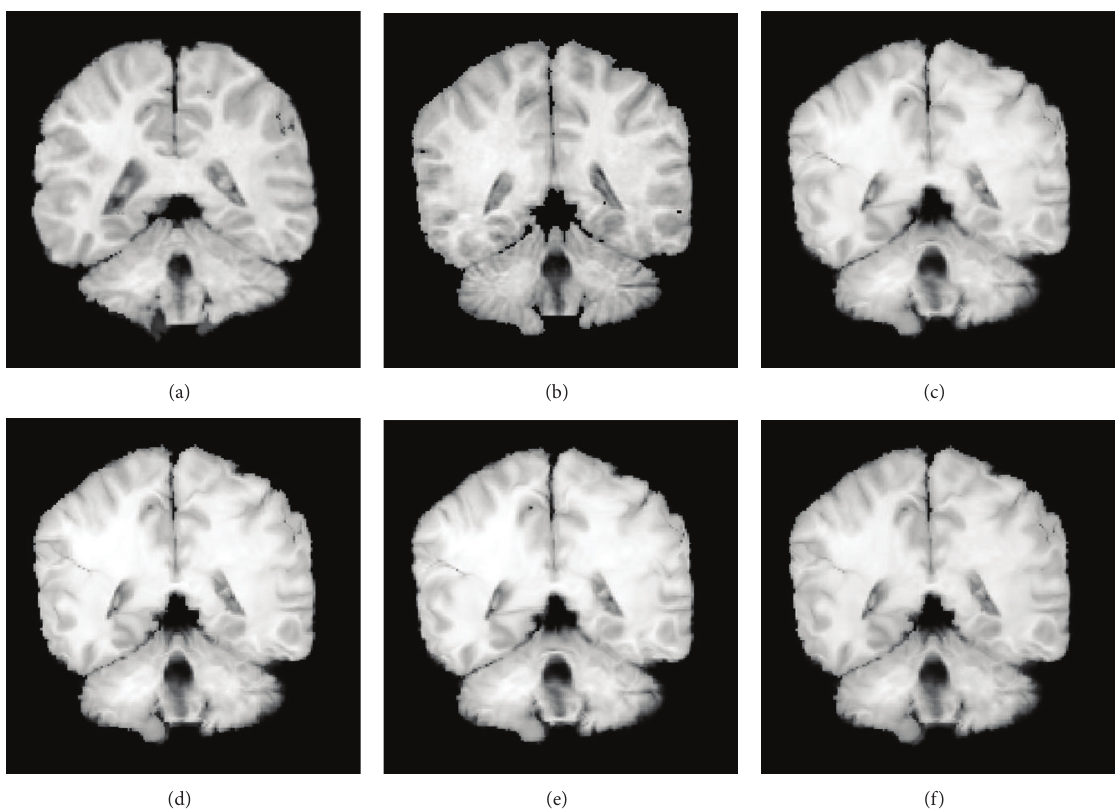
Figure 5: An example of the results of the 24th slice with various methods on IBSR Database is shown. (a) Floating image. (b) Target image. (c) The result of the fluid model with standard force (FMSF). (d) The result of the fluid model with adaptive force (FMAF). (e) The result of the Maxwell model with standard force (MMSF). (f) The result of the Maxwell model with adaptive force